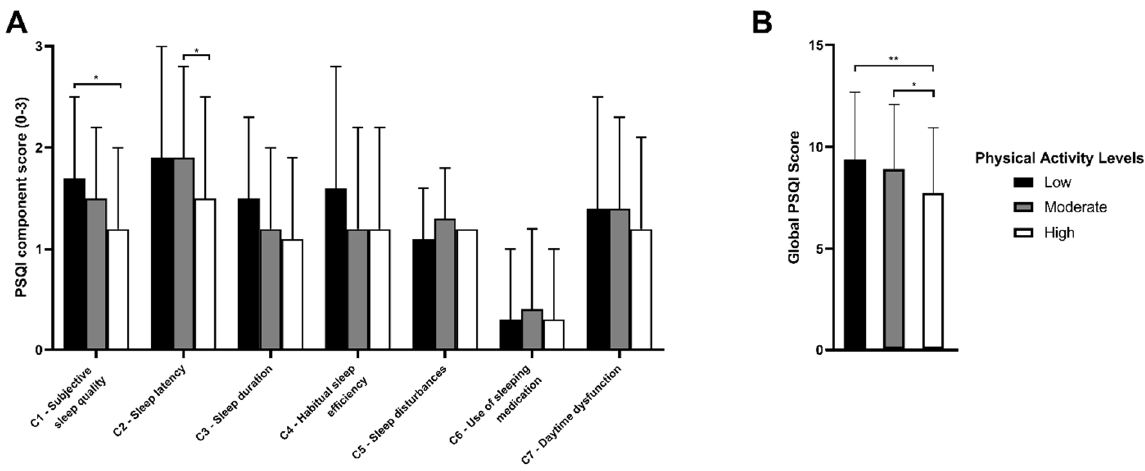
Figure 1. PSQI score according to physical activity level. ( A ) Mean PSQI component score according to IPAQ classification. ( B ) Mean global PSQI score according to IPAQ classification. Pittsburgh Sleep Quality Index; SE, standard error. Data are expressed as the mean with error bars. * p < 0.05; ** p < 0.01.